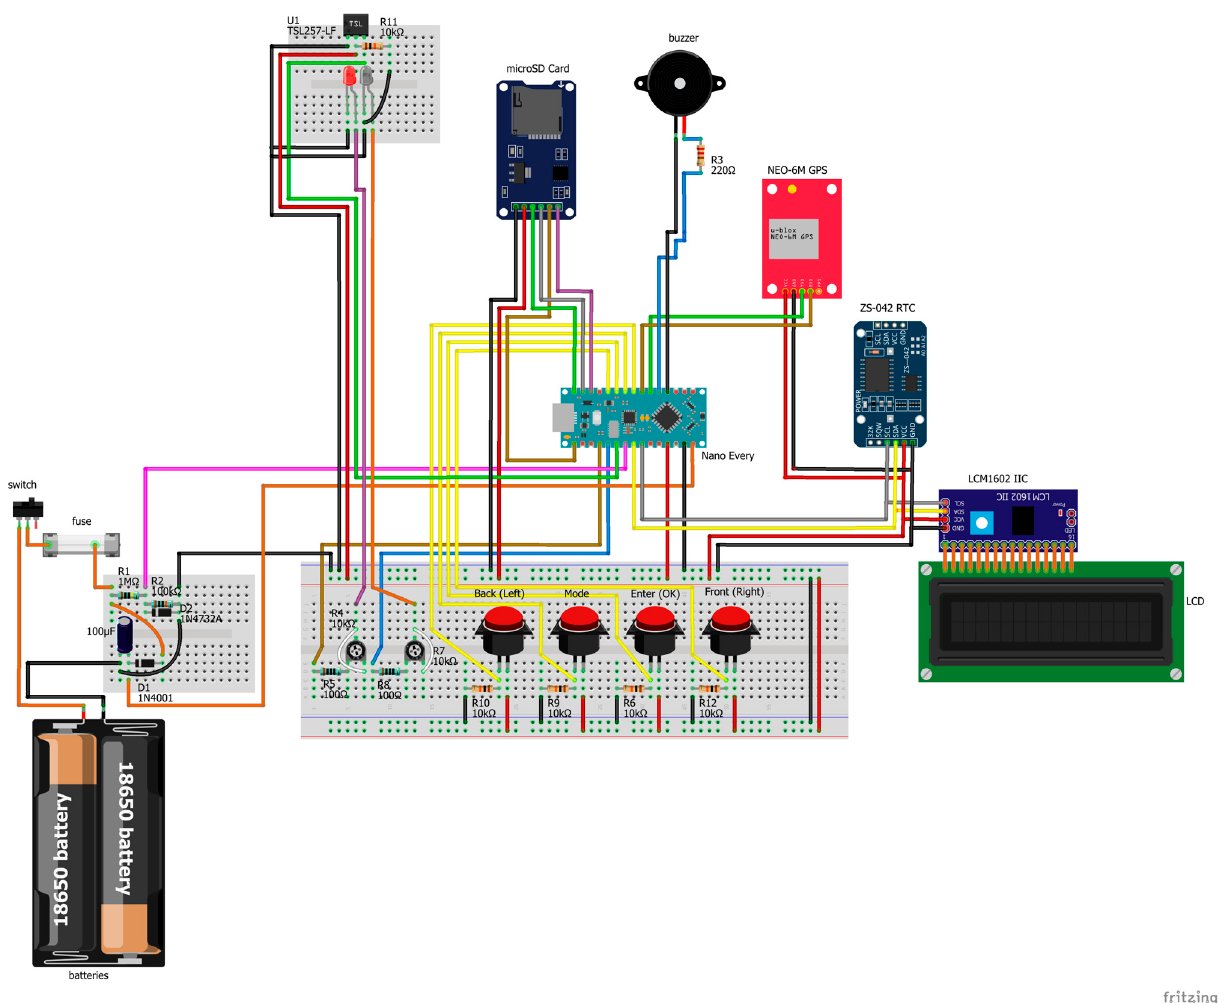
Figure 3. The wiring diagram of the experimental chlorophyll meter device’s prototype.